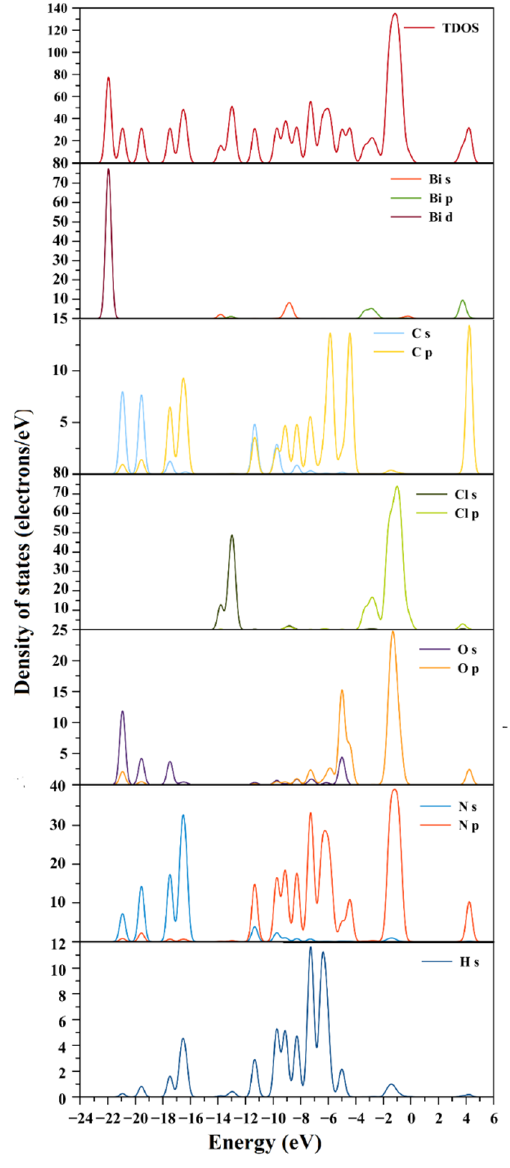
Figure 10. Total and partial densities of states for (C 2 H 7 N 4 O) 2 BiCl 5 using GGA/PBE functional.